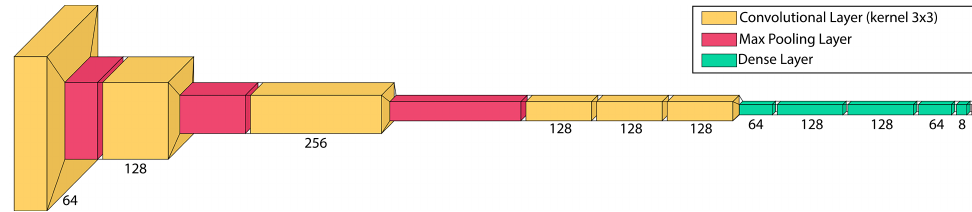
Figure 10. Structure of the custom convolutional neural